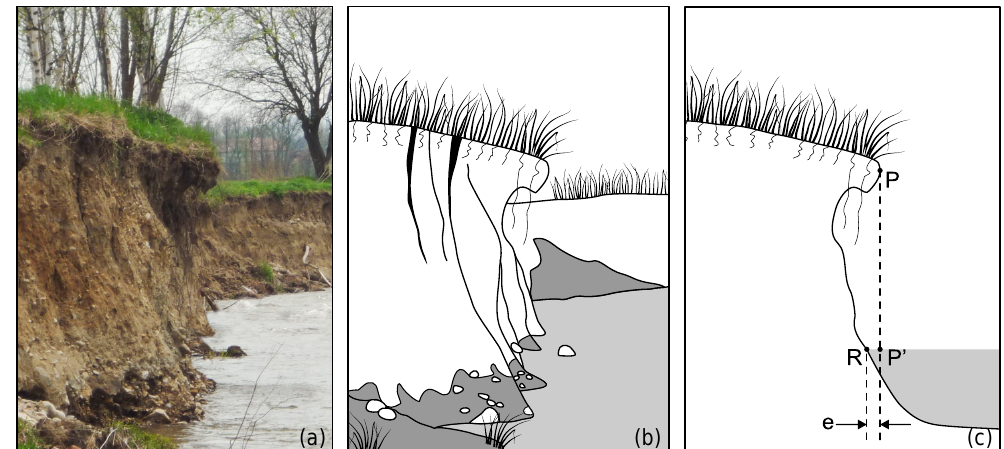
Figure 4. Undercut river bank: (a) photograph, (b) three-dimensional (3-D) sketch, (c) 2-D cross section with edge P and its projection onto water surface P (cid:48) (water surface visible from the UAV) as well as true bank R (UAV-unobservable water surface, denoted in the figure as “ e ”, stretches between R and P (cid:48)